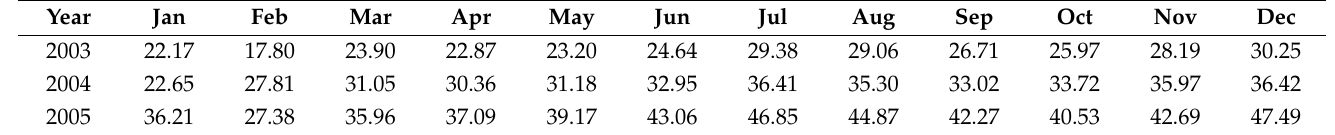
Table 2. Monthly data of industrial power consumption in Suzhou from 2003 year to 2005 year.